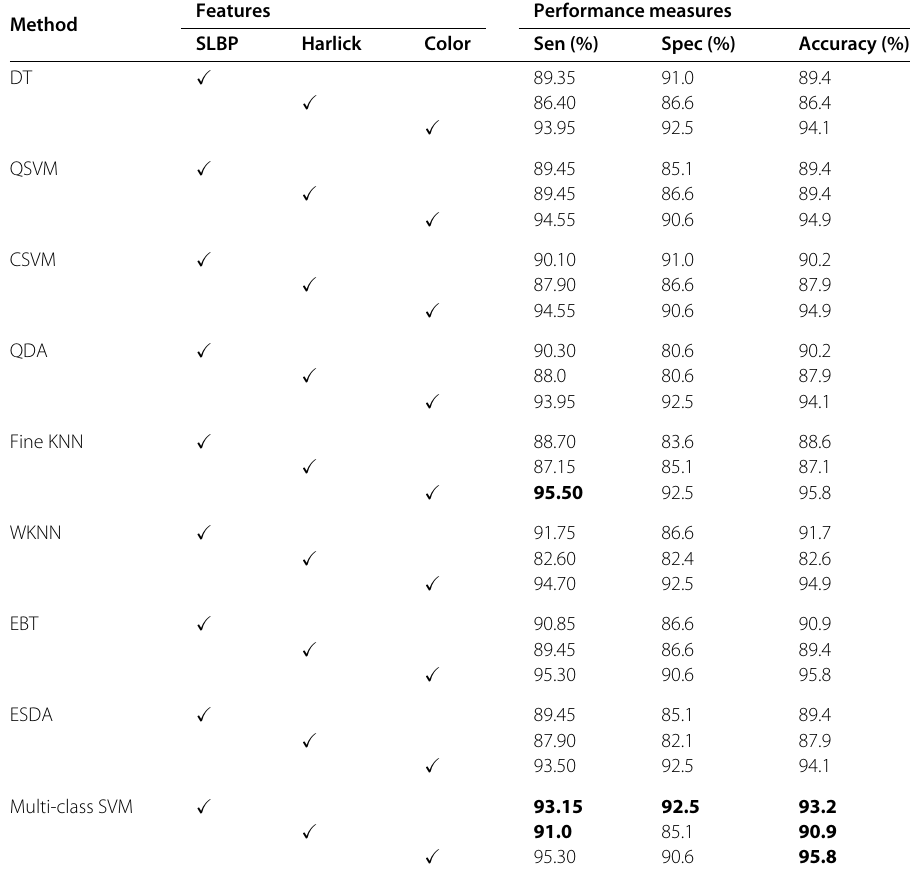
Table 10 Classification result on each extracted set of features for grapes rot leave disease Method